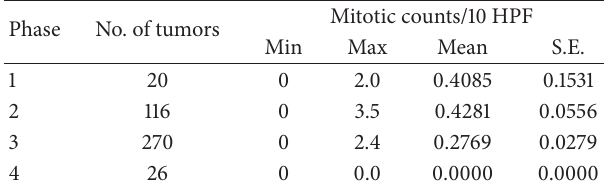
Table 2: Mitotic counts of tumors in Phases 1–4.